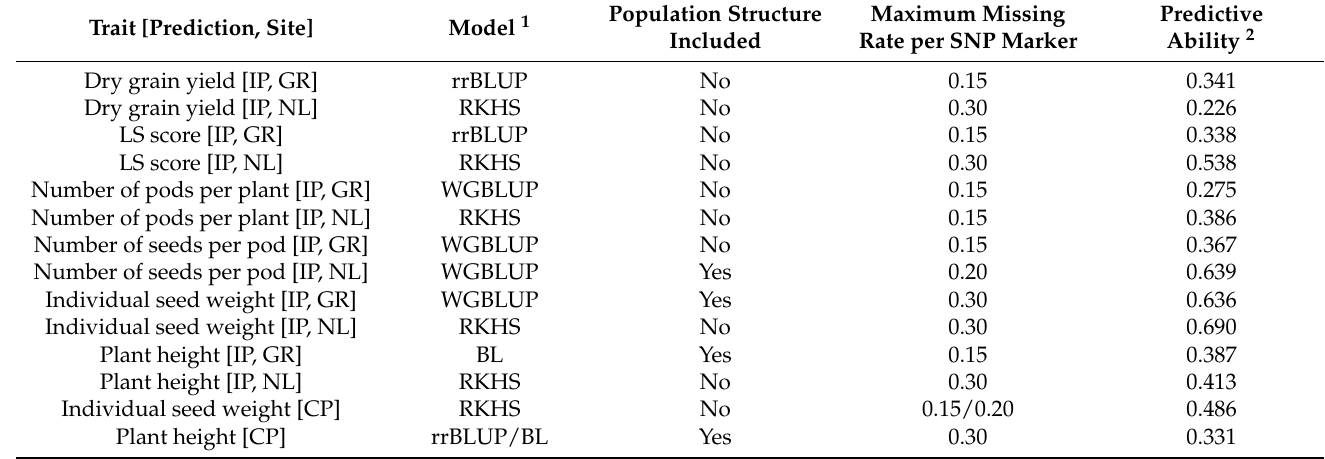
Table 4. Predictive ability (as Pearson’s correlation between true and predicted phenotypes) of best-performing genomic selection models for intra-environment prediction (IP) of white lupin grain yield, the average value of a visual lime susceptibility (LS) score, three grain yield components and plant height observed in Larissa (GR, Greece) and Ens (NL, the Netherlands), and average value of best-performing models for cross-environment prediction (CP) of individual seed weight and plant